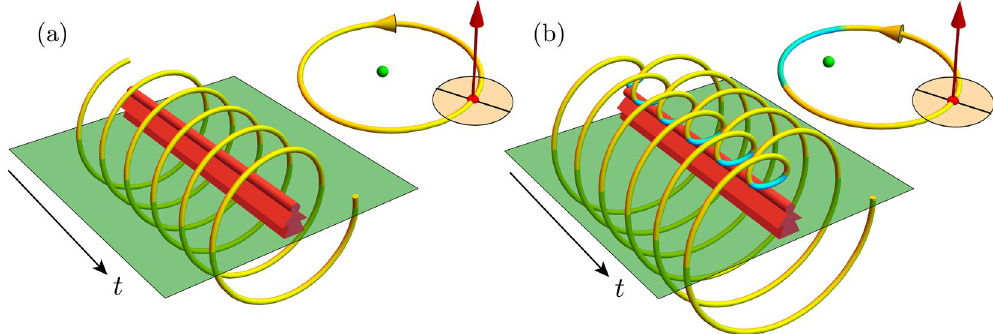
Figure 2. Coil plots. Spacetime extrusions (red) represent equatorial observers on their local horizons (green). ( a ) Earth-like planet with { ρ , e } = { 2, 0.1 } , with orbit (top right) and apparent solar motion (bottom left) where sun apparently rises in the east and sets in the west with no reversals. ( b ) Exoplanet with { 2, 0.5 } , with orbit (top right) and apparent solar motion (bottom left), including reversals (cyan) near periapsis and noon. Equatorial observer at the antipodes would not see the solar